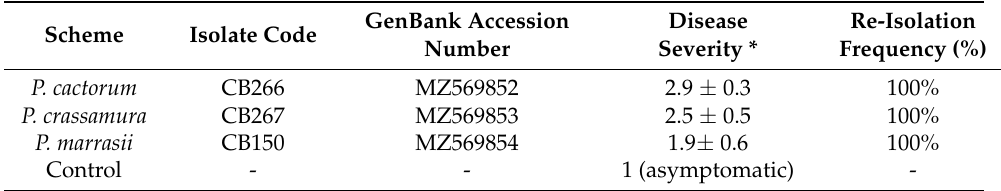
Table 3. Disease severity detected on globe artichoke plants inoculated with the representative Phytophthora isolates obtained in this